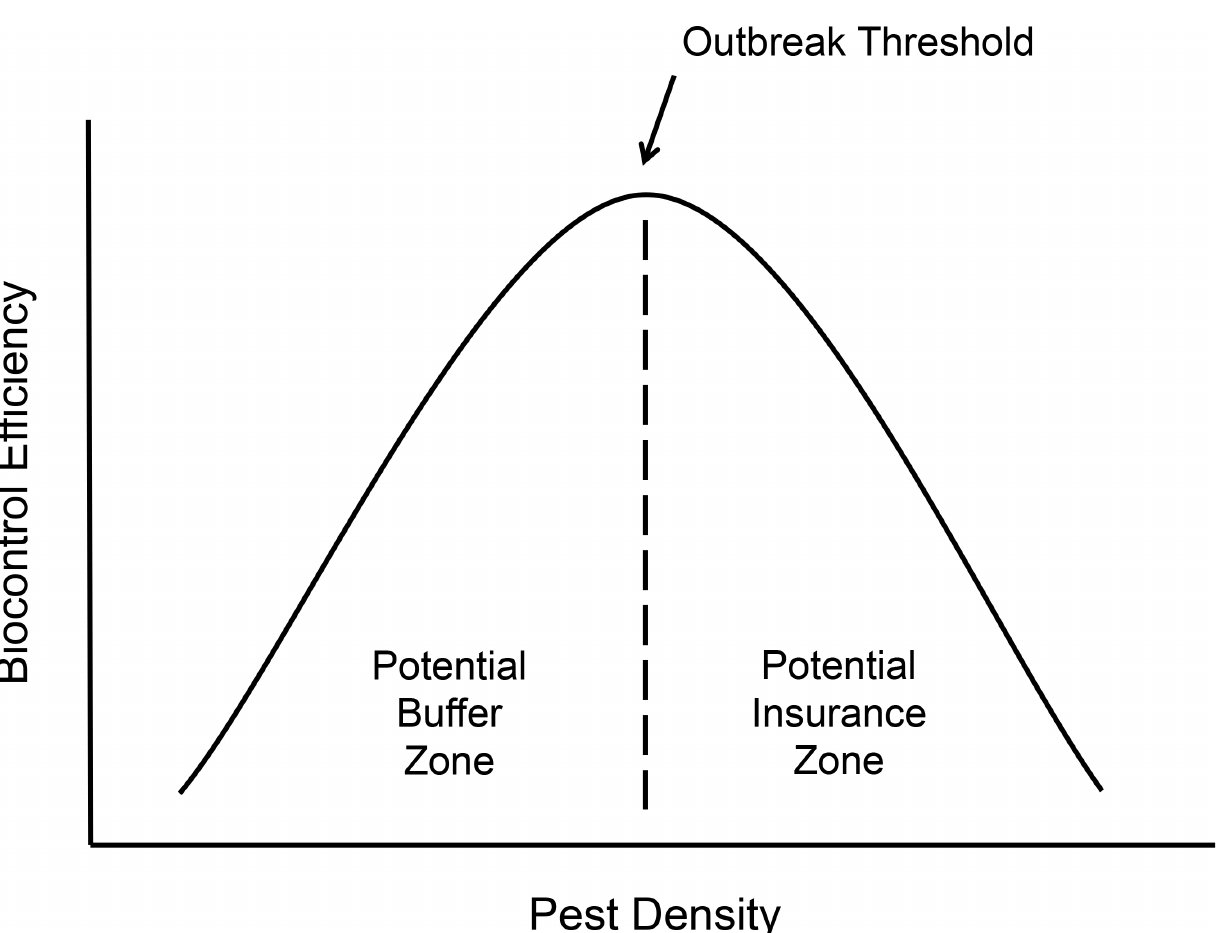
Fig 1. Hypothesized biological control efficiency (BCE) dynamics. As pest density increases, the overall efficiency of natural enemies to control pest infestation will likely vary, resulting in zones with different management implications. Here we define biocontrol efficiency (BCE) as the proportion of pests that are prevented from infesting or damaging crops by a predator. In our study we expect BCE to initially increase with increasing pest density, perhaps as ants switch to the more abundant prey. This could result in a potential buffer zone where ants help to buffer the pest outbreak. Eventually, however, BCE may drop off, as ants satiate or become overwhelmed at higher pest densities. This could create a potential pest outbreak threshold, which would result in an insurance zone where farmers would need to rely on the insurance of other natural enemy species to compensate for the decreased biocontrol efficiency.